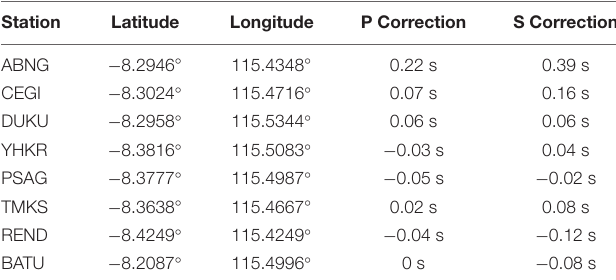
TABLE 1 | Station corrections of each local station surrounding Agung volcano obtained through joint hypocenter location, velocity model, and station correction inversion which were performed in this